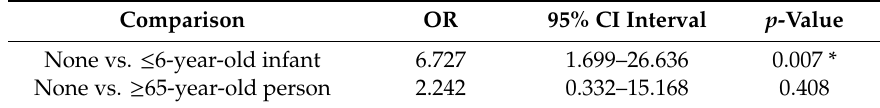
Table 3. Binary logistic regression analysis for risk factor associated with anxiety.